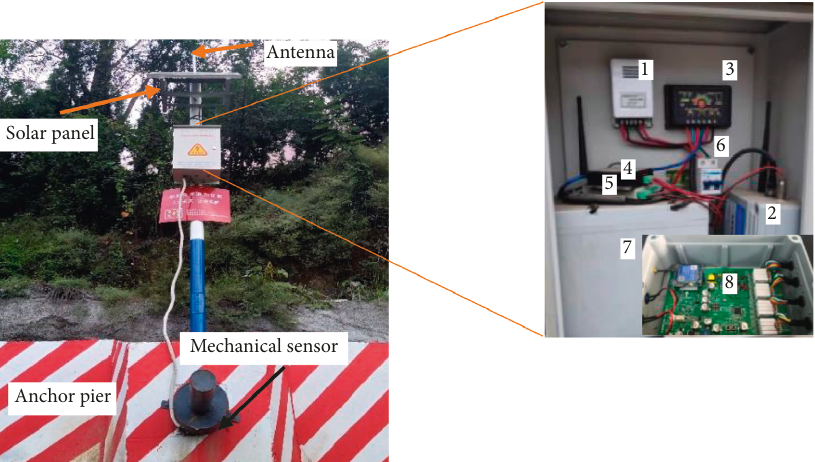
Figure 10: Outdoor system equipment:1, power supply (12V); 2, power supply (9V); 3, solar controller; 4, communication node; 5, GPRS- DTU; 6, switch; 7, solar battery; 8, data acquisition device.